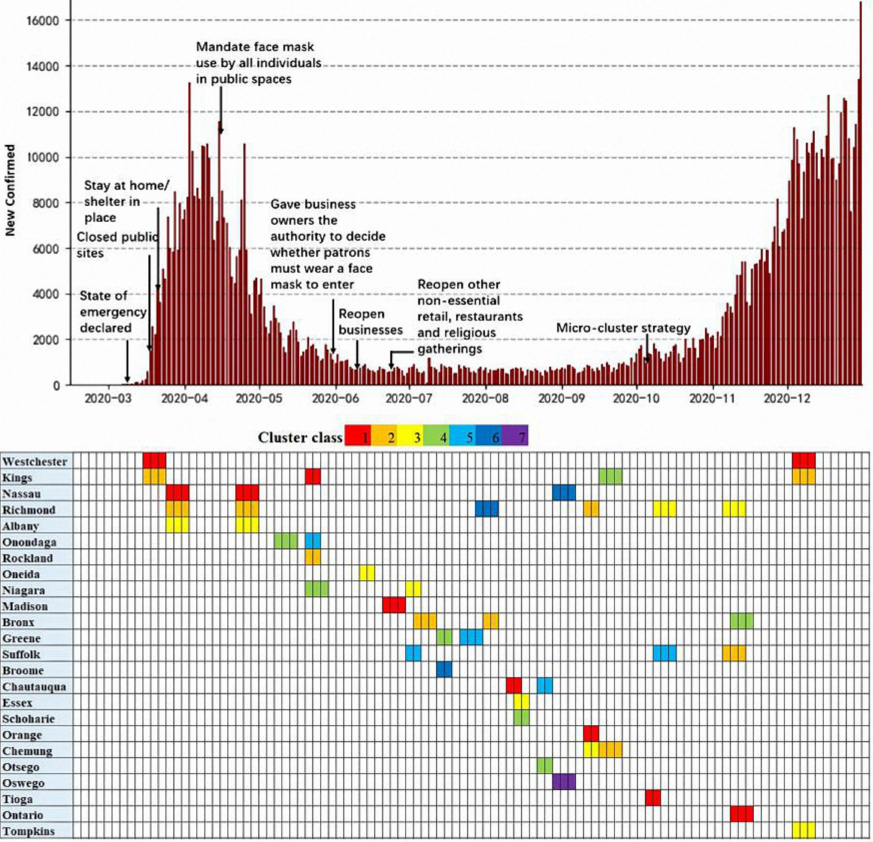
Figure 4. Timeline of newly confirmed cases, clusters, and related epidemic prevention policies of COVID-19 in New York State (the upper part shows the time series of the daily confirmed cases with the public health interventions, and the lower part shows the timeline and cluster time for each